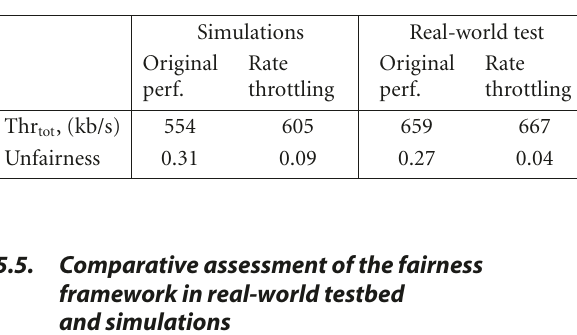
Table 2: The e ff ect of rate throttling in the case of flows with vari- able